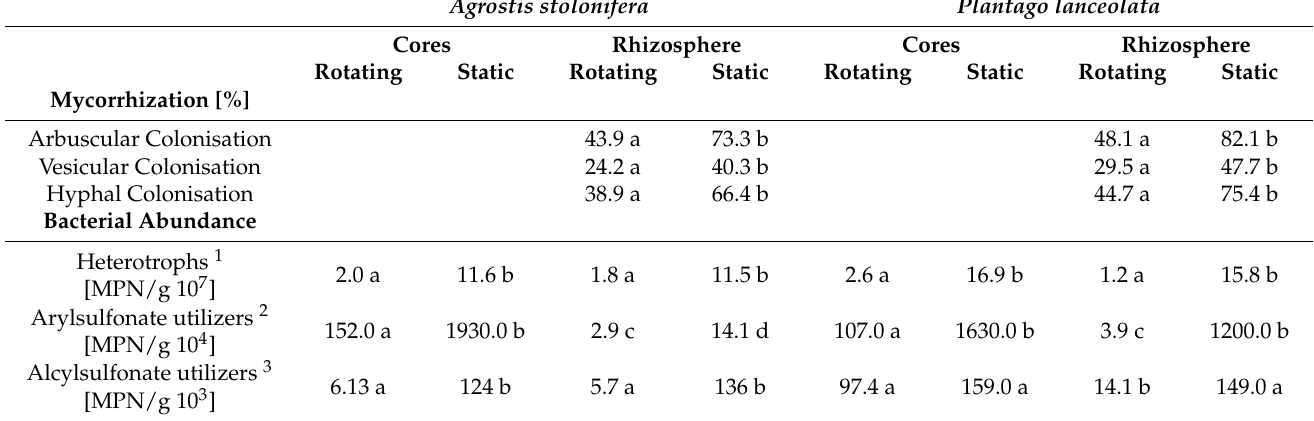
Table 1. Arbuscular mycorrhizal colonisation and abundance of cultivable bacteria (most probable number, MPN) from static and rotating cores as well as rhizospheres from microcosms with static and rotating cores ( n = 6). Letters (a–d) indicate significant differences in mycorrhization and bacterial abundances across cores and rhizospheres (static and